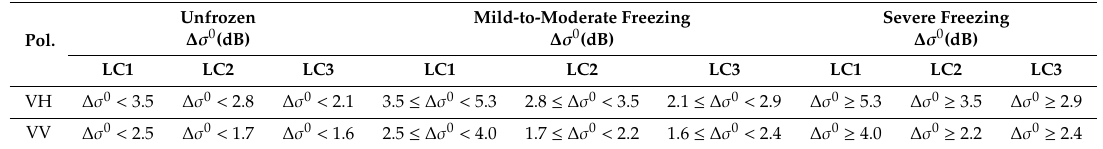
Table 1. Calculated thresholds for each land cover class (LC) in VV and VH polarizations. Figure 5. Distributions of ª㣆 ଴ in VH polarization for the three main land cover classes: ( a , d ) cereals LC1, Pol. ( b , e ) meadows LC2, and ( c , f ) orchards and vineyards LC3. ( a , b , and c ) ª㣆 ଴ over LC1, LC2, and LC3, respectively, for temperatures  3 °C  t  0 °C, ( d , e , and f ) ª㣆 ଴ over LC1, LC2, and LC3, respectively, for t   3 °C. The Y-axis represents the frequency of different ª㣆 ଴ ranges over the entire plots. The red curve represents the fitted normal functions, while the red vertical line represents the mean.